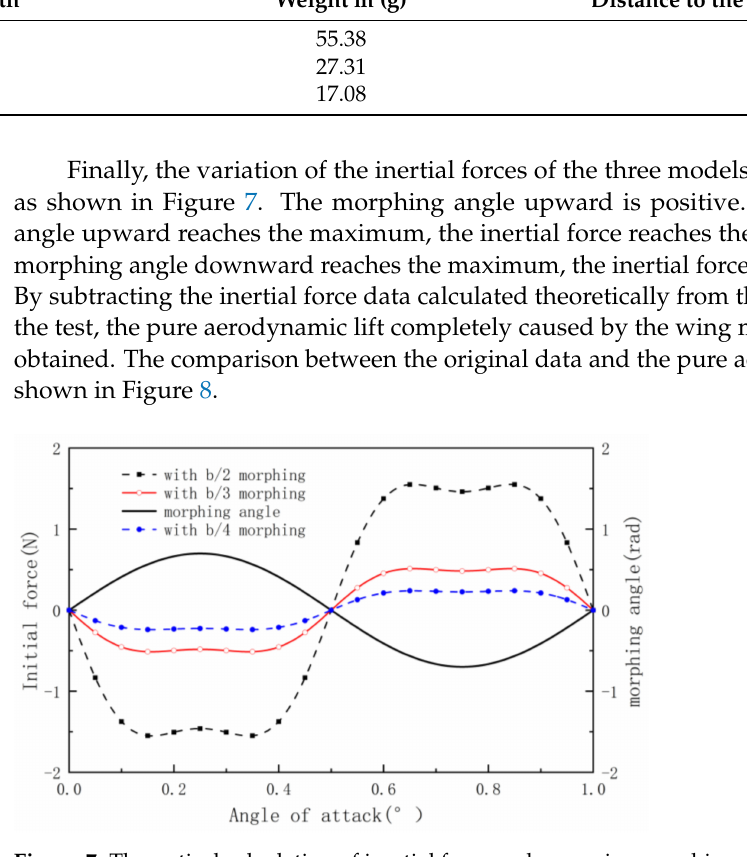
Figure 7. Theoretical calculation of inertial force and spanwise morphing angle.